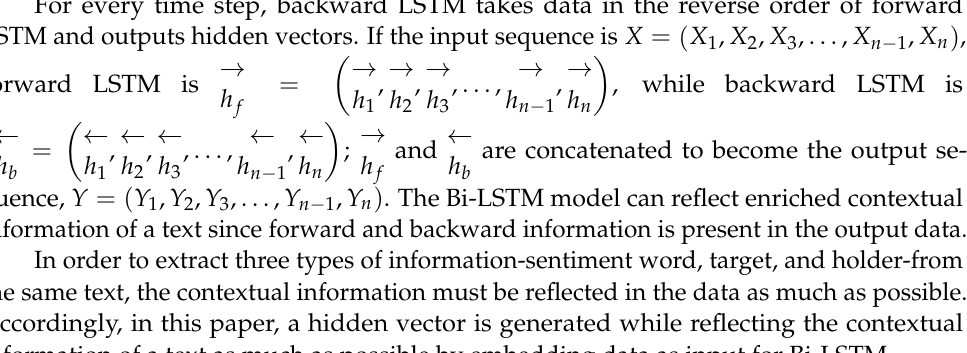
Figure 6. The architecture of Bi−LSTM.